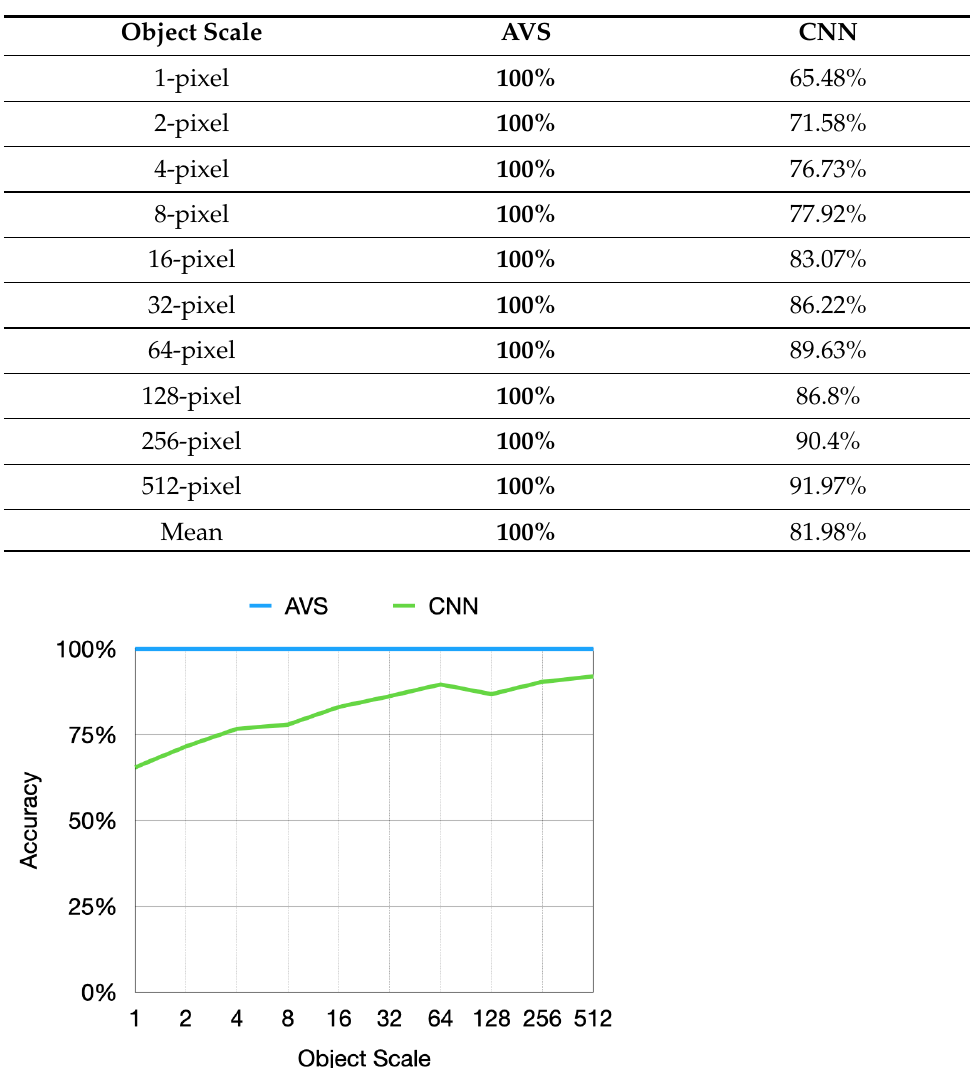
Table 2. The experimental results of AVS and CNN in motion direction detection on different scales of objects.